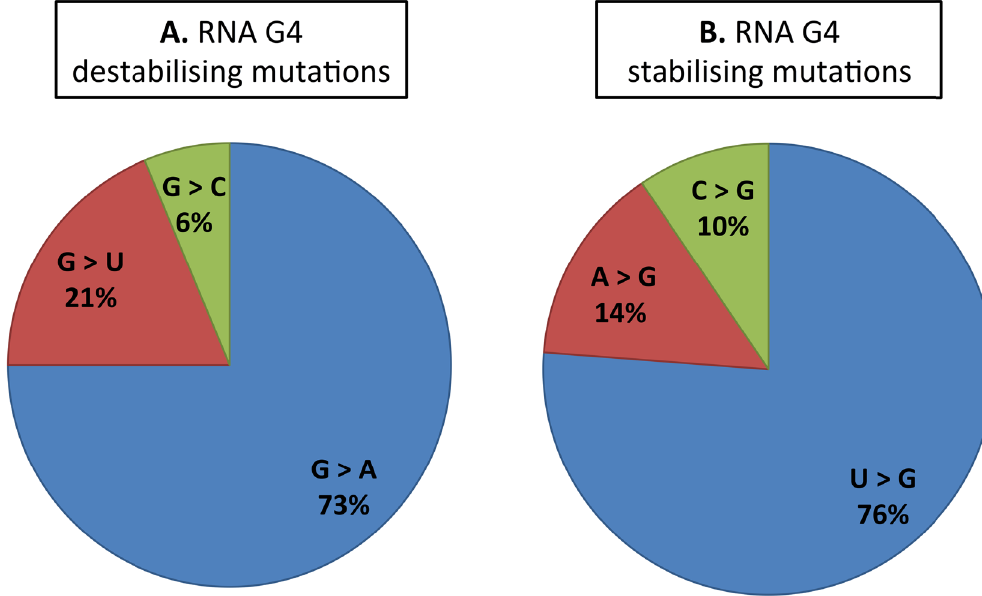
Figure 2. Pie chart demonstrating the frequency of different type of mutations in each of the RNA G4 ( A ) destabilising and ( B ) stabilising mutation